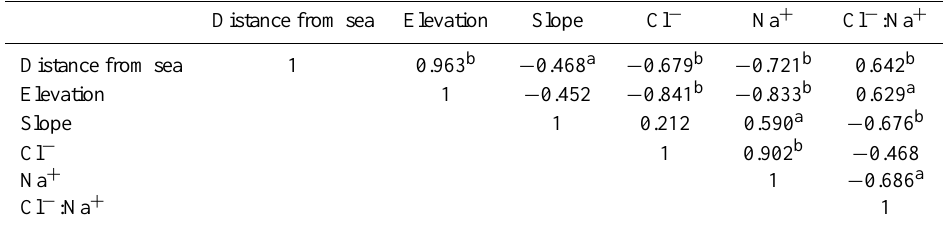
Table 3. Correlation coefficients ( r ) between the site specific features and Na + and Cl − ions. Correlations are based on annual ion concentration data. Values marked with a and b represent correlations that are significant at 95% and 99% respectively.